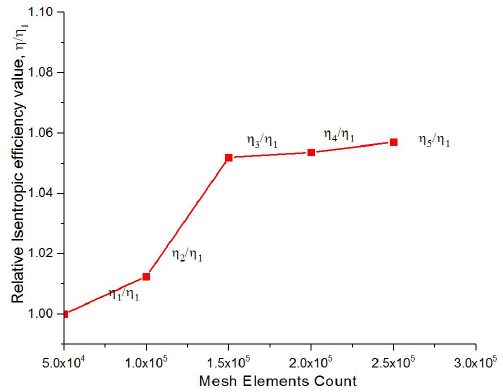
Figure 2. Mesh independence test for impeller without tip clearance configuration.